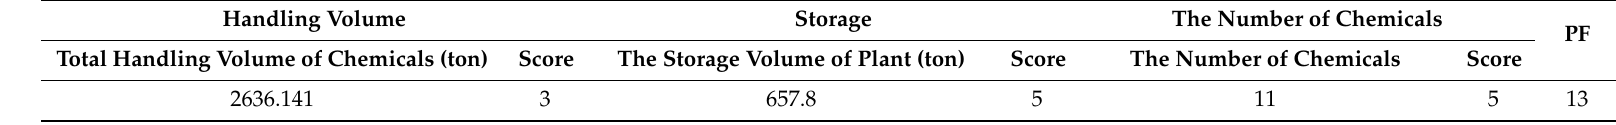
Table 3. The scoring to the plant factor (PF) of example